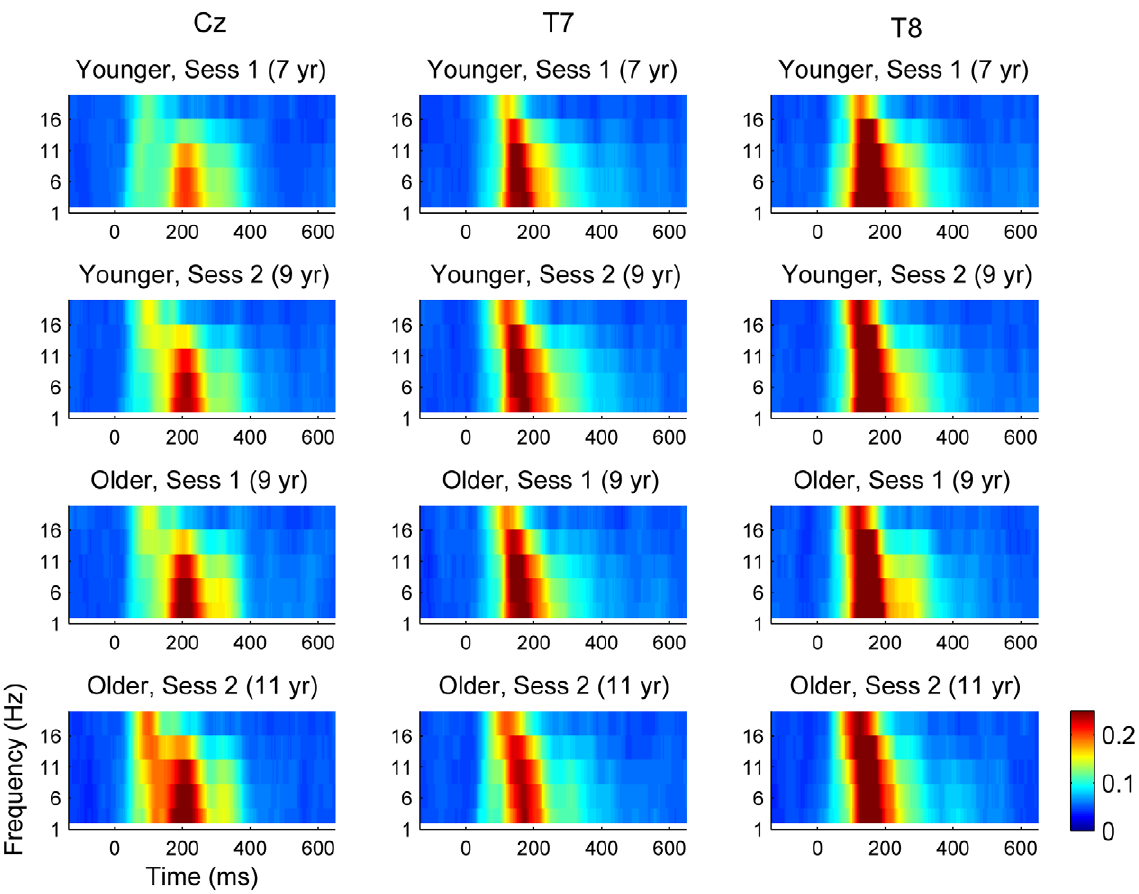
Figure 2. ITC at electrodes Cz, T7 and T8. Mean ITC by time (x-axis) and frequency (y-axis) in relation to group and session. Color bar indicating range from zero, i.e. no synchronization (green) to ITC of 0.2 (deep red). ANOVA indicated that ITC at lower frequencies tends to increase with age at fronto-central electrodes, but remains stable or declines with age at temporal sites.